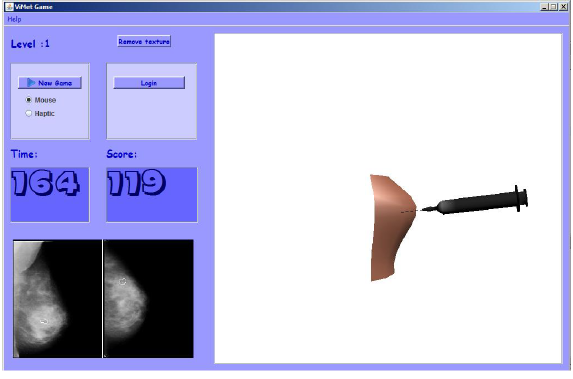
Figure 11. Level of the game with realist objects.